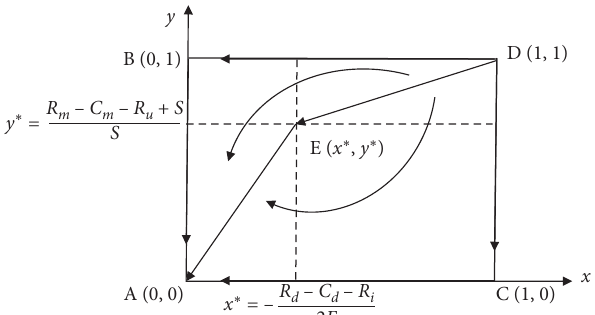
Figure 9: The replication dynamic phase map for scenario (17).